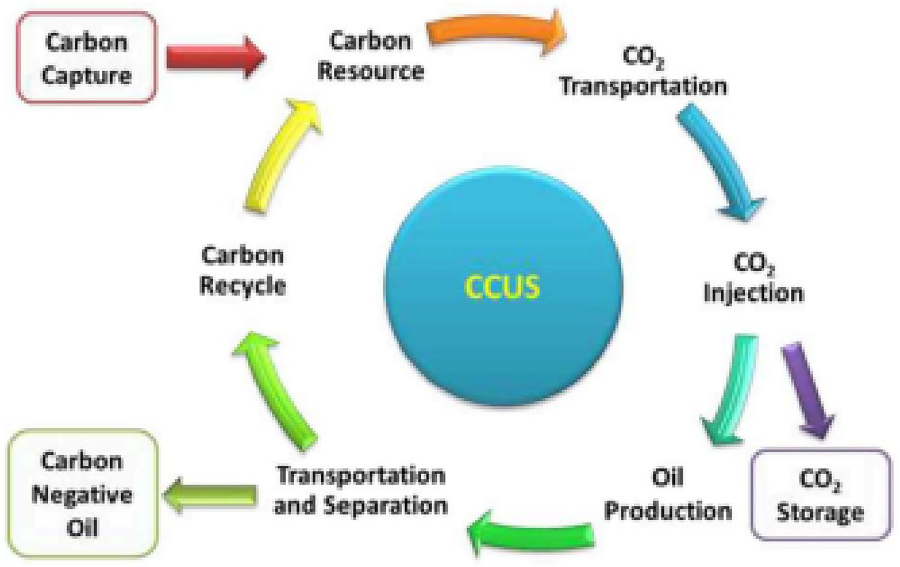
Fig. 2 CCUS chain process by (Wang et al.